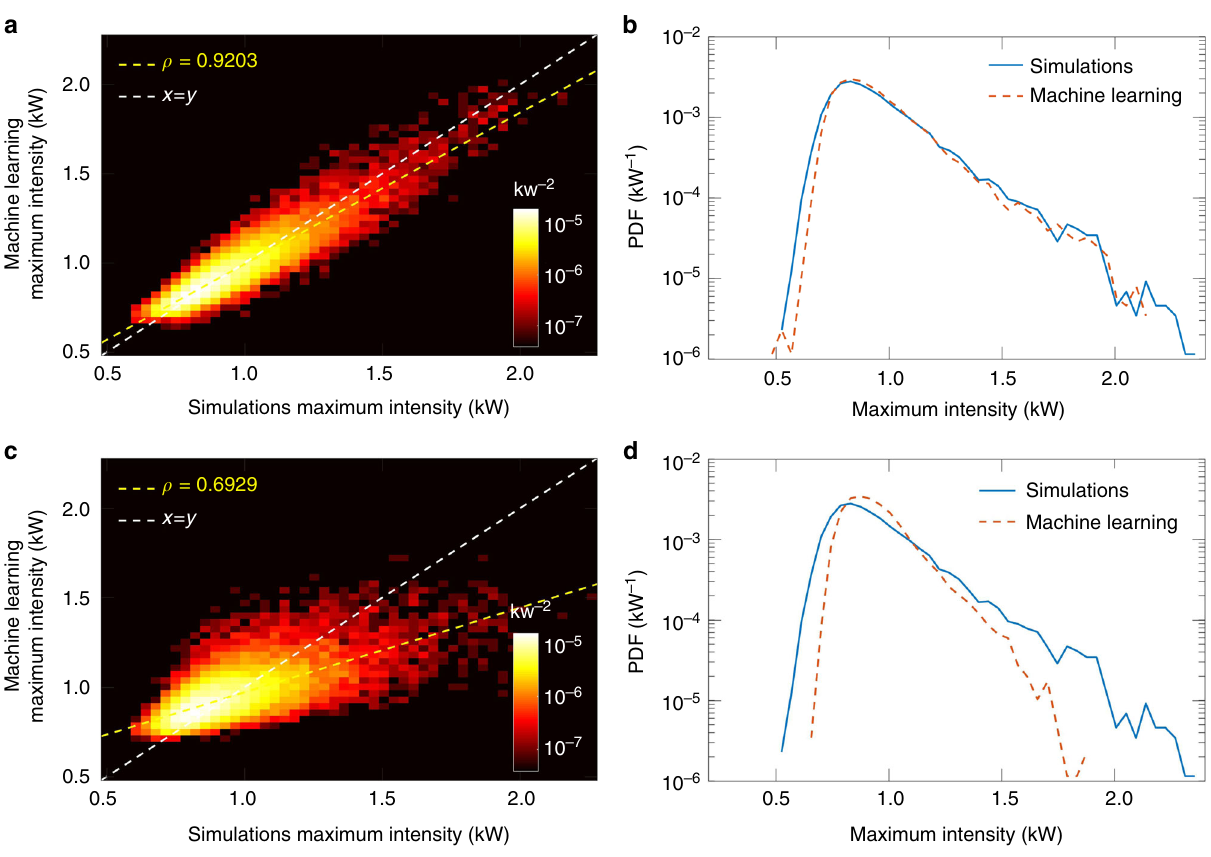
Fig. 3 Supervised learning analysis of 50,000 simulated MI spectra. a , c A comparison is shown of the “ predicted ” maximum intensity (instantaneous peak power) from the machine learning algorithm with the exact “ target ” value from the simulated time-domain data. The top and bottom panels correspond to truncating the input spectra data at 60 dB (except on the long wavelength side, see main text) and 25 dB dynamic range (typical for standard fi bre-DFT), respectively. The results in a and c are shown as a false colour representation of a histogram which shows in logarithmic scale the normalised density of points grouped into bins of constant area. The dashed white line marks the 1-to-1 correspondence between the maximum intensity (instantaneous peak power) predicted by the machine learning algorithm with the exact value from the simulated time-domain data. The value ρ in the legend is Pearson's correlation coef fi cient. b , d Probability density function (PDF) of the maximum temporal intensities predicted by the machine learning algorithm (red line) compared with the PDF calculated from the simulated time-domain data (blue line). An ensemble of 20,000 simulated single-shot spectra (distinct from the training data) was used for the